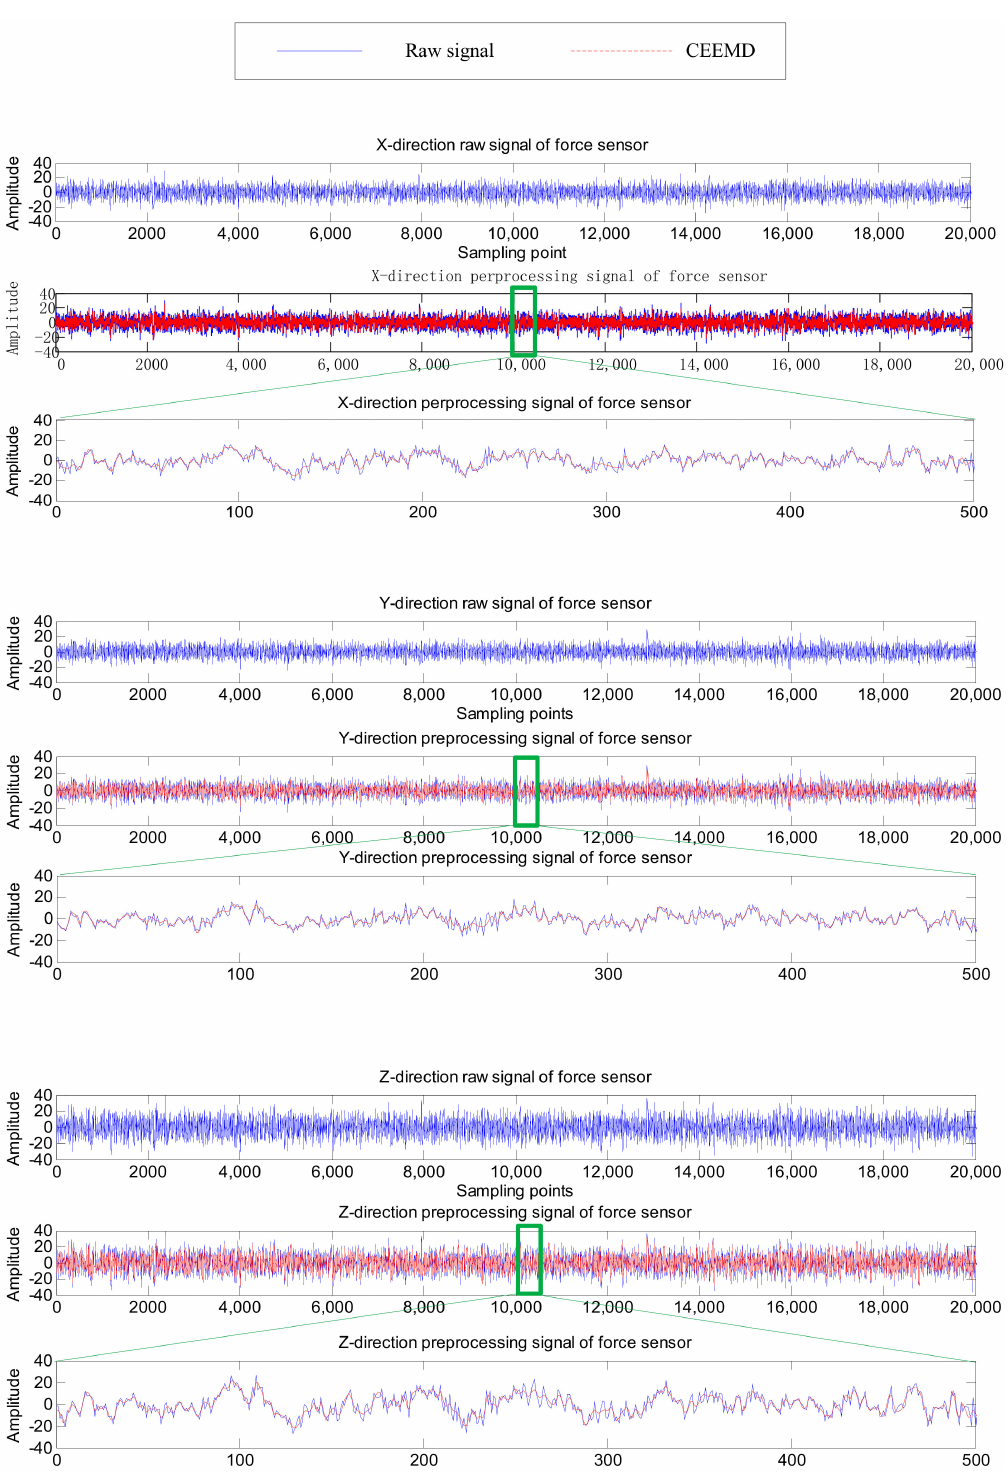
Figure 7. The raw and preprocessed signals of force sensor in one